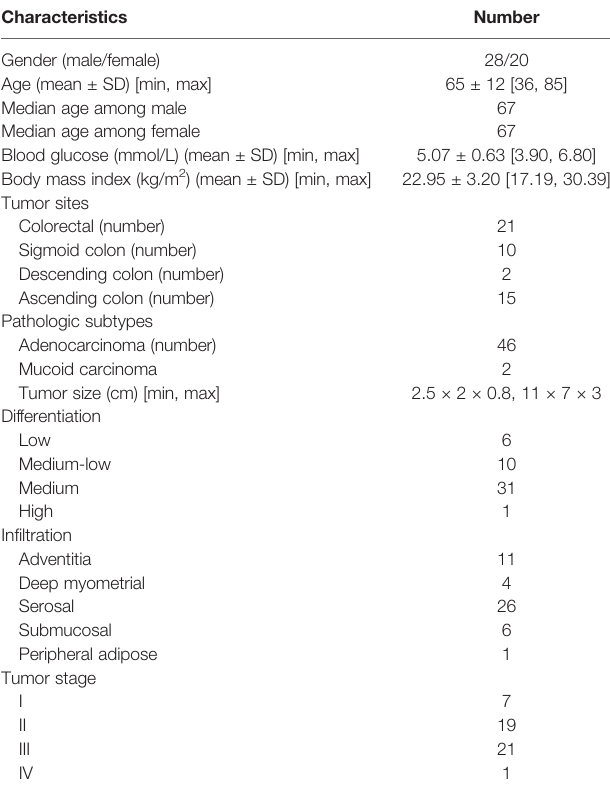
TABLE 1 | Clinical features of colorectal cancer patients enrolled in this study.